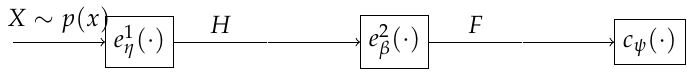
Figure 6. Neural Network architecture